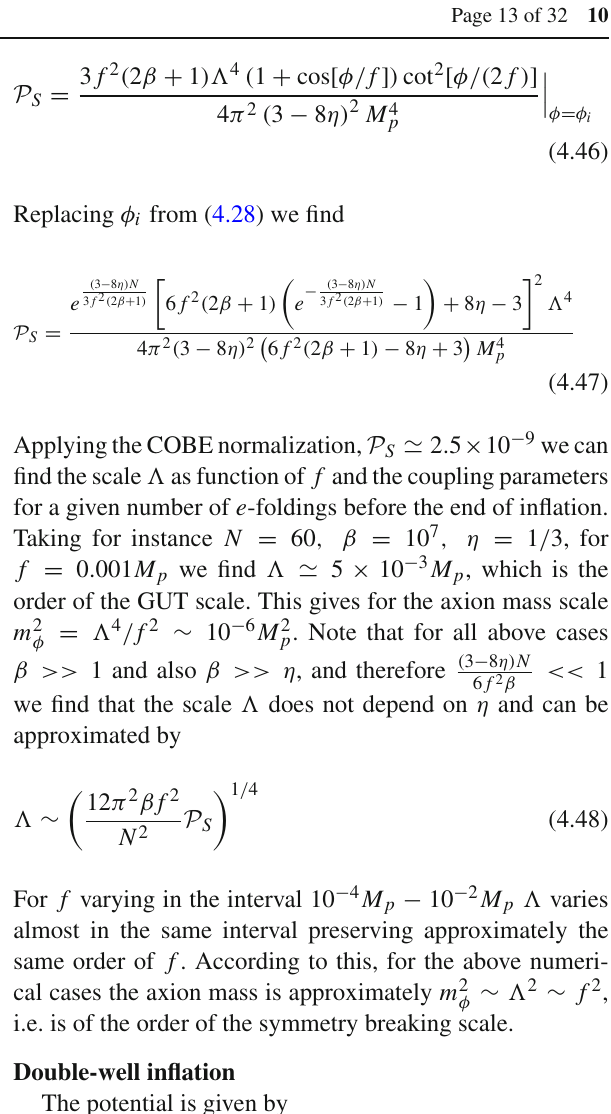
n s ∼ 0 . 96 −− 0 . 97, and the tensor/scalar ratio can take values bellow the bound 0 . 05 without getting too